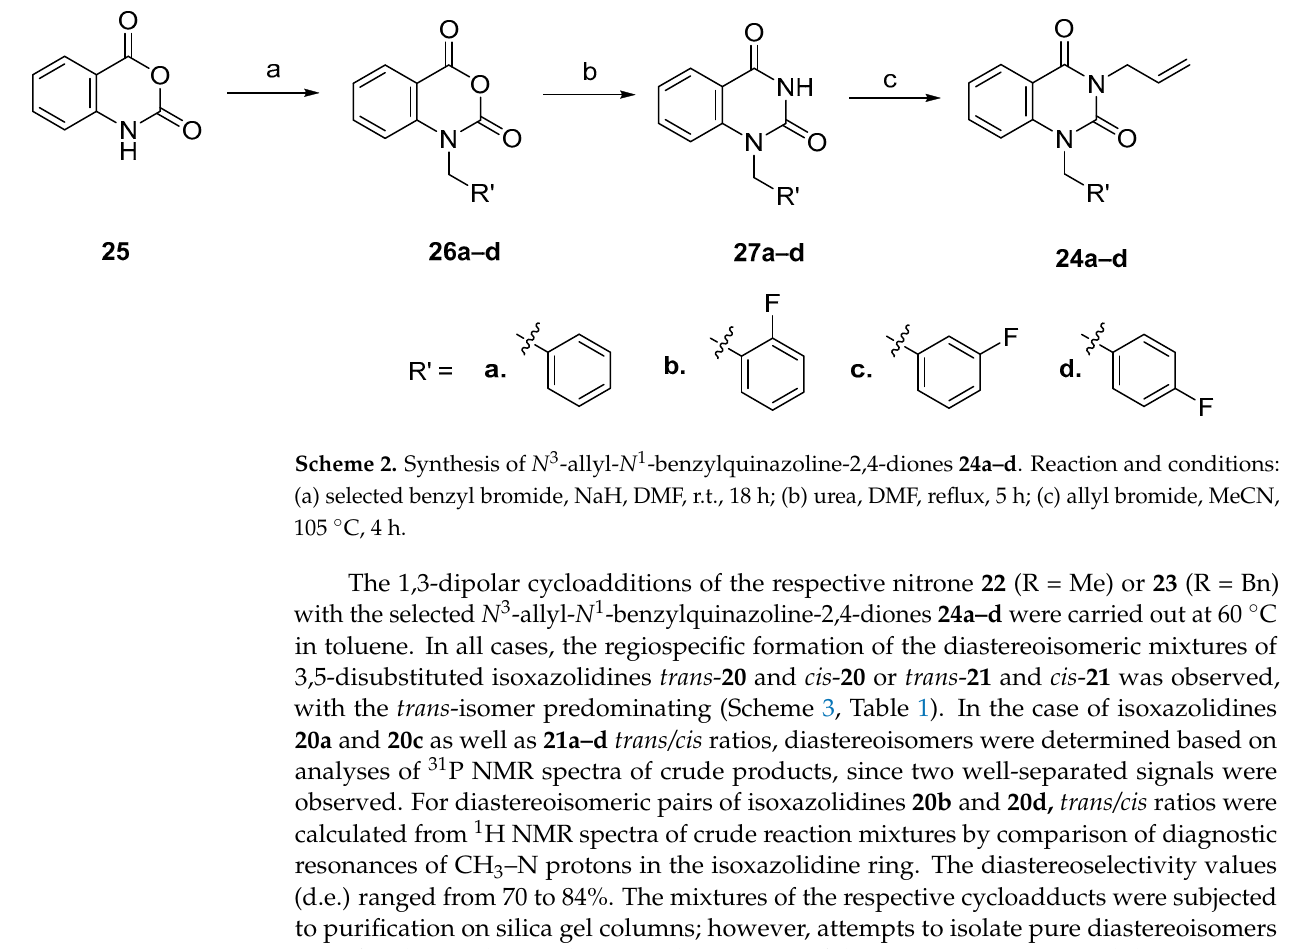
cis -21d + trans - 21d (84) a a Yield of pure mixture of cis - and trans -isomers. The relative configurations of the isoxazolidine cycloadducts trans - 20 and cis - 20 or trans - 21 and cis - 21 were established by taking in account our previous studies on the ste- reochemistry of cycloaddition of N-substituted C -diethyoxyphosphonylated nitrones 22 and 23 with allylated derivatives of various (hetero)aromatic compounds [21,22], includ- ing N3-substituted N1-allylquinazoline-2,4-diones [18]. Since modification of the substit- uents in quinazoline-2,4-dione moiety, including the relocation of substituents at N1 and N3, has no influence on the stereochemical outcome of the cycloaddition of nitrones 22 and 23 to N-allylquinazoline-2,4-dione dipolarophiles, configurations of all major isoxa- zolidines 20 and 21 were assigned trans , while minor isomers were assigned cis , by anal- ogy to previously established configurations of trans - and cis -isoxazolidines 12a–c [18]. 2.2. Antiviral and Antimicrobial Evaluation 2.2.1. Antiviral Activity All synthesized alkenes 24a – d and the respective diastereoisomeric mixtures of isox- azolidines cis - 20a / trans - 20a (10:90), cis - 20b / trans - 20b (8:92), cis - 20c / trans - 20c (6:94), cis - 20d / trans - 20d (10:90), cis - 21a / trans - 21a (10:90), cis - 21b / trans - 21b (15:85), cis - 21c / trans - 21c (10:90), and cis - 21d / trans - 21d (15:85) were tested for inhibitory activity of a wide variety of DNA and RNA viruses, using the following cell-based assays: (a) human embryonic lung (HEL) cells: herpes simplex virus-1 (KOS), herpes simplex virus-2 (G), herpes sim- plex virus-1 (TK – KOS ACV r ), cytomegalovirus (AD-169 strain, Davis strain), varicella- zoster virus (TK + VZV OKA strain and TK – VZV 07-1 strain), vaccinia virus, adenovirus- 2, human coronavirus (229E); (b) HeLa cell cultures: vesicular stomatitis virus, Coxsackie virus B4, respiratory syncytial virus; (c) Vero cell cultures: para-influenza-3 virus, reovi- rus-1, Sindbis virus, Coxsackie virus B4, Punta Toro virus, yellow fever virus; and (d) Ma- din–Darby canine kidney (MDCK) cell cultures: influenza A virus (H1N1 and H3N2